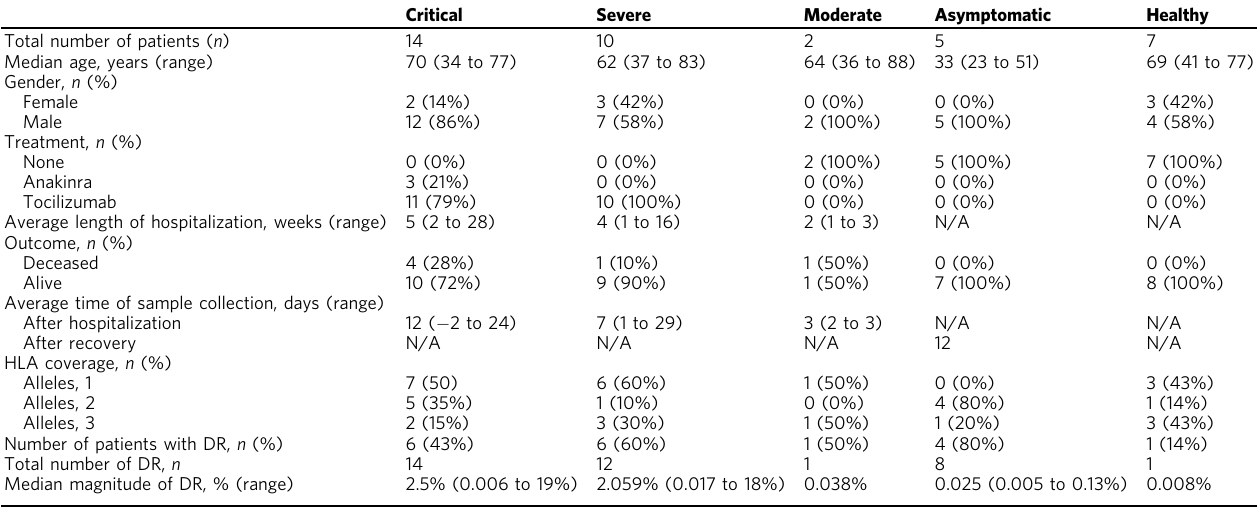
Table 1 Characteristics of COVID-19 patients included in the analysis of SARS-CoV-2-speci fi c CD8 T cell responses. Critical Severe Moderate Asymptomatic Total number of patients ( n